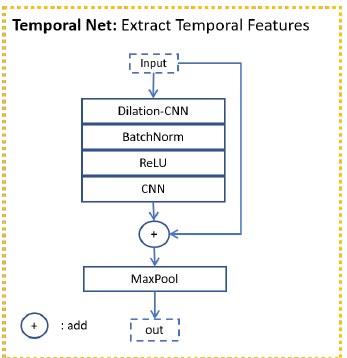
Figure 4. Backbone for visual modality.